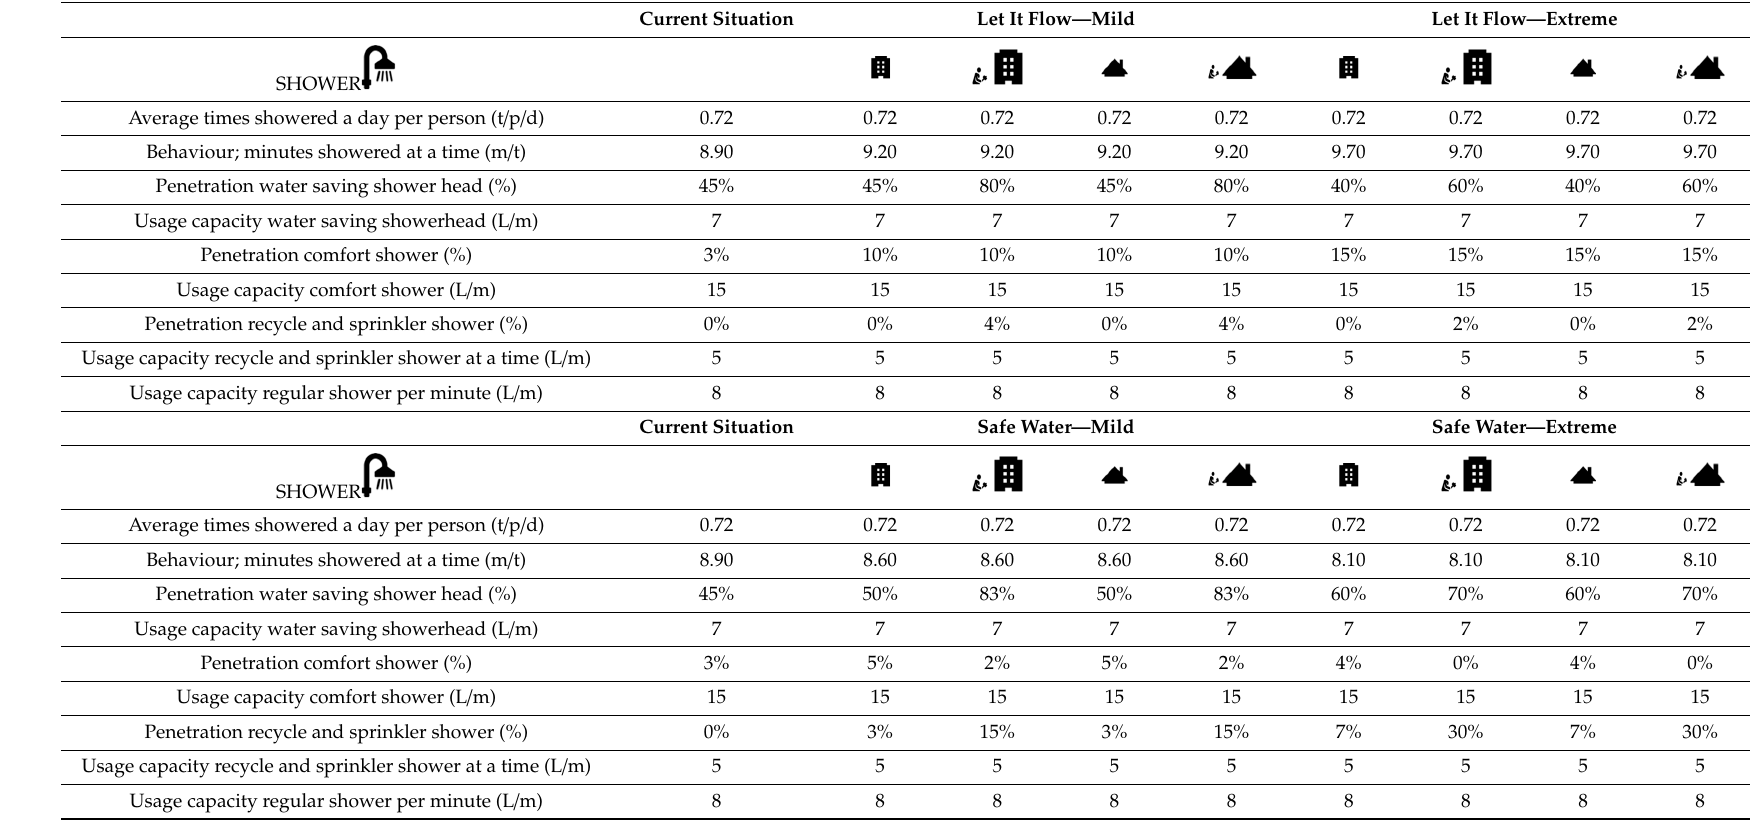
Table A3. Quantitative input data for individual water demands (STEP 6).